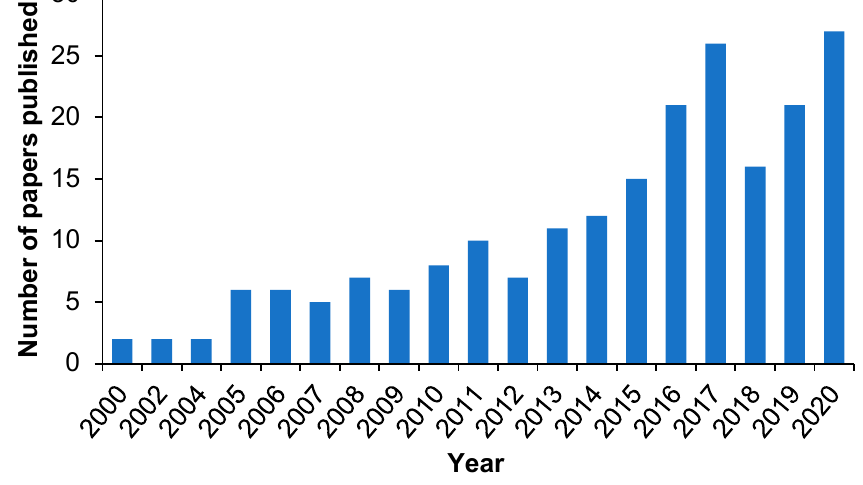
Figure 2. Number of published papers on MIP-based DDSs in the years 2000–2020. Source: PubMed .